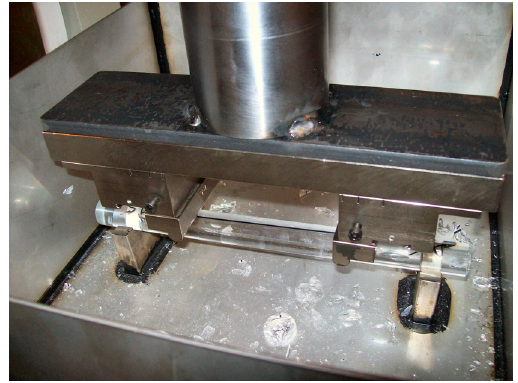
Figure 1: Test rig for glass bars.